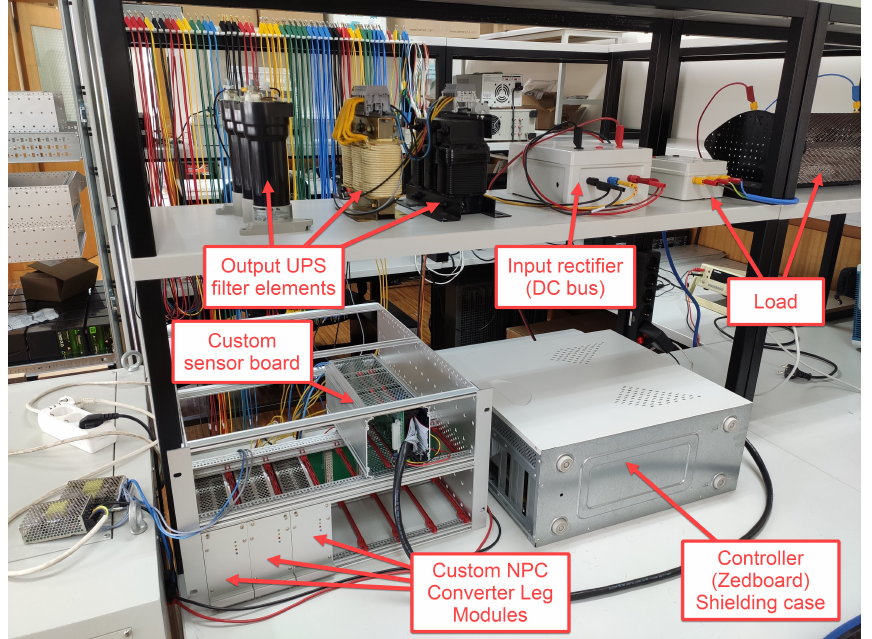
Figure 29. Experimental UPS inverter prototype